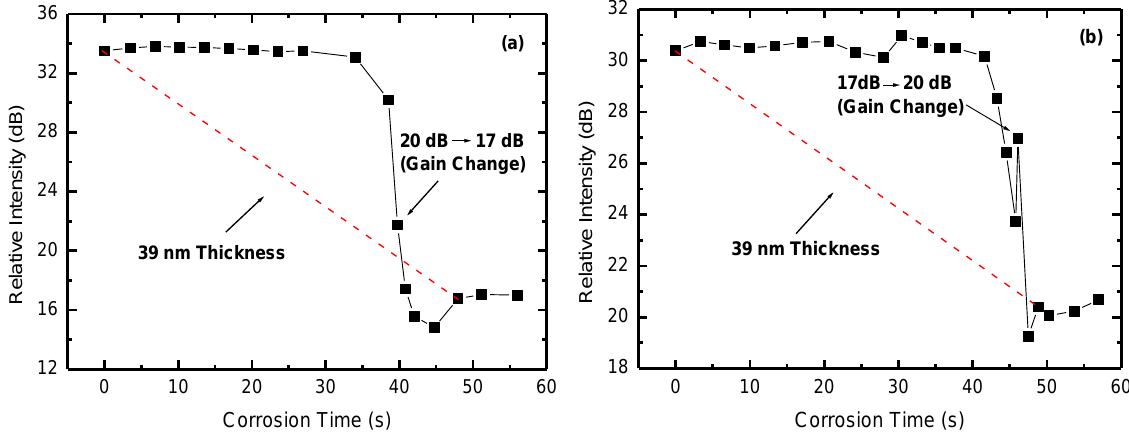
Figure 7. OTDR relative intensity (B-A’) for the corrosion of the Al film under gain changes: ( a ) from 20 dB to 17 dB and ( b ) from 17 dB to 20